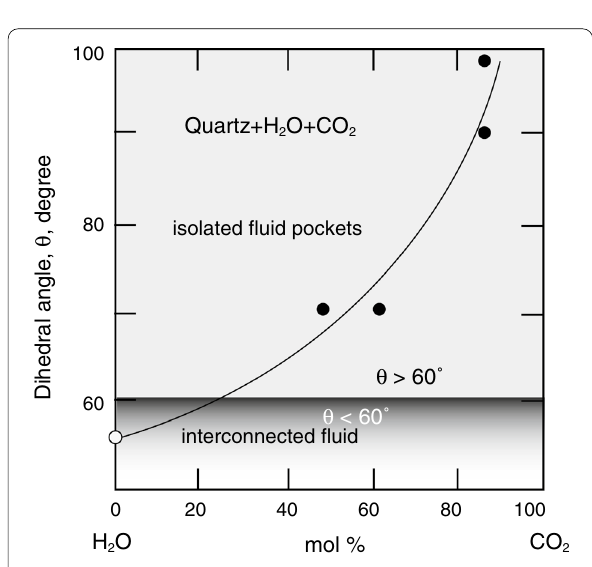
Fig. 36 Dihedral angle in quartz-H 2 O–CO 2 at 1 GPa and 950°-1150 °C as a function of fluid composition. Modified from Watson and